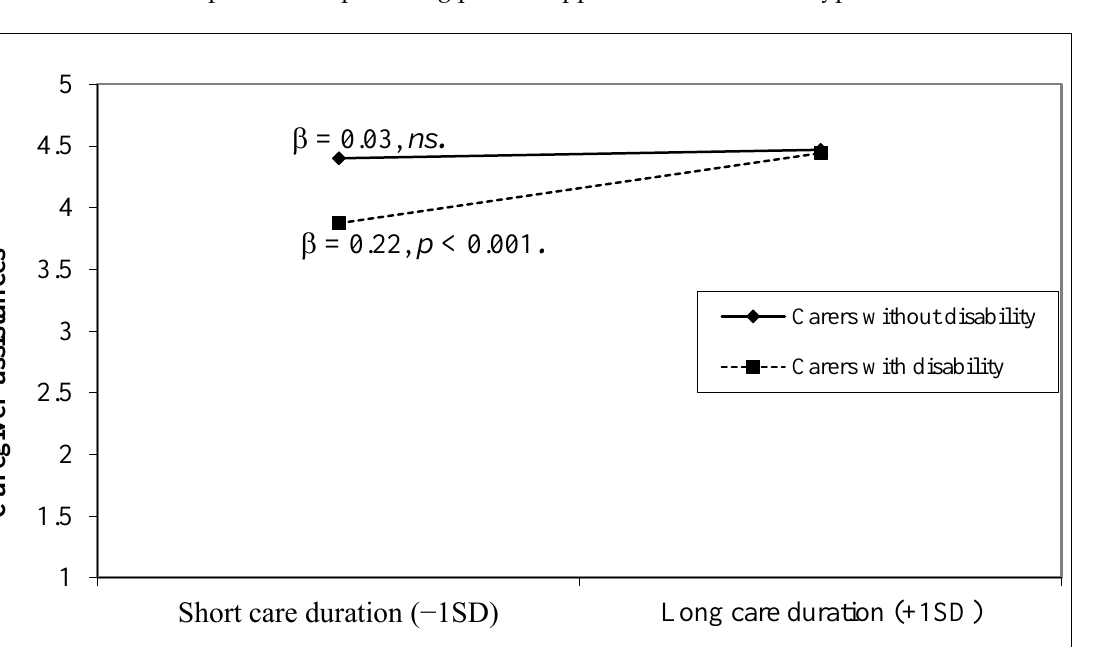
Figure 3. Relationship between care duration and perception of the importance of service improve- ment among carers on financial subsidy. 5. Discussion The current study examined the hypothesis that double disadvantage in carers of individuals with a disability in Hong Kong may account for the perceived importance of service improvement, in which the disability status of carers themselves may alter the impacts of care duration on the types of service improvement needs. We found that longer care duration predicted higher levels of perceived importance of service improvements in